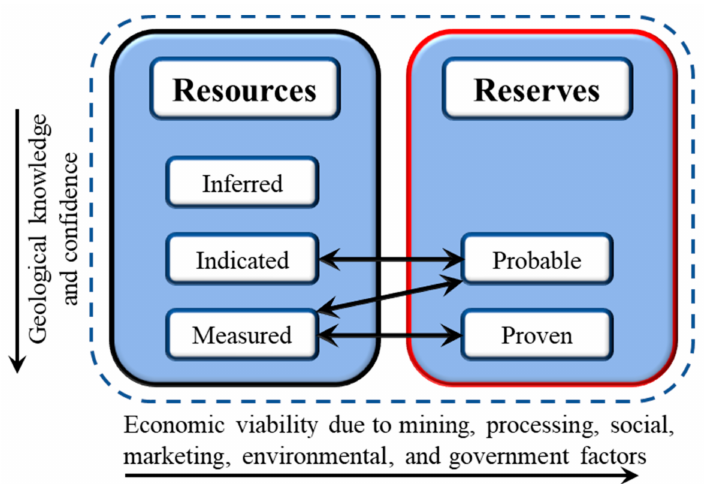
Figure 1. A general relationship between mineral resources and mineral